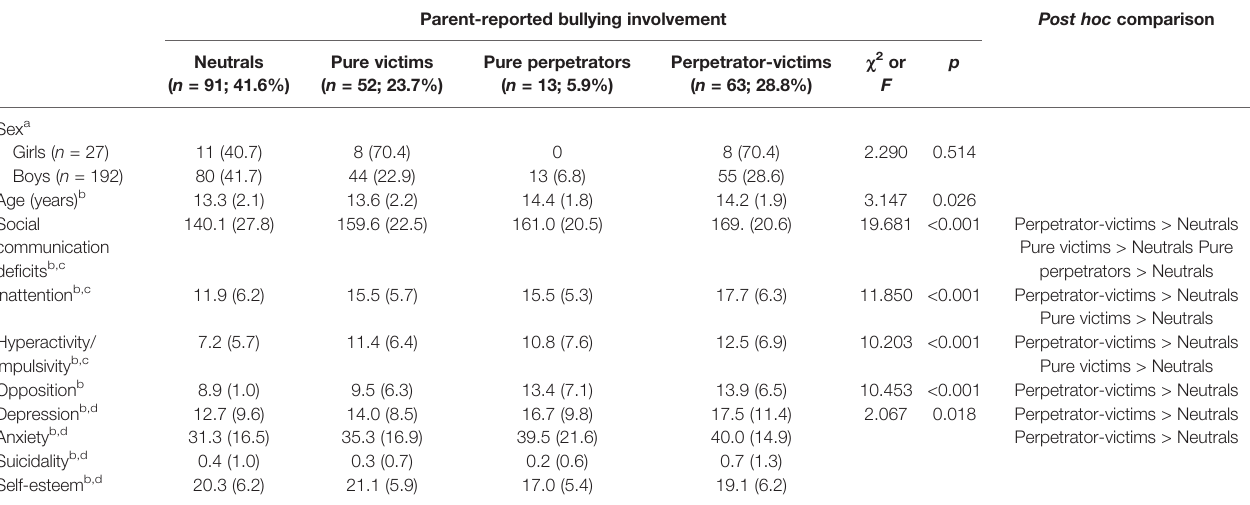
TABLE 3 | Sex, age, social communication de fi cits, inattention, hyperactivity/impulsivity, opposition, depression, anxiety, suicidality, and self-esteem among the groups of various parent-reported bullying involvement ( N = 219). Parent-reported bullying involvement Post hoc